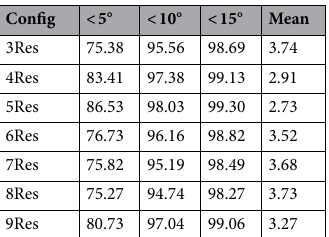
Table 2. Comparison of model performance with different number of residual blocks.